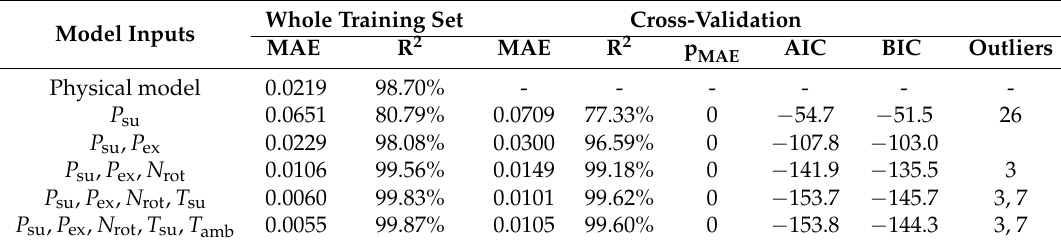
Figure 10. Mean absolute error (MAE) for different combinations of inputs and for the physical model. Table 1. Main analysis results for different models. Akaike information criterion: AIC; Bayesian information criterion: